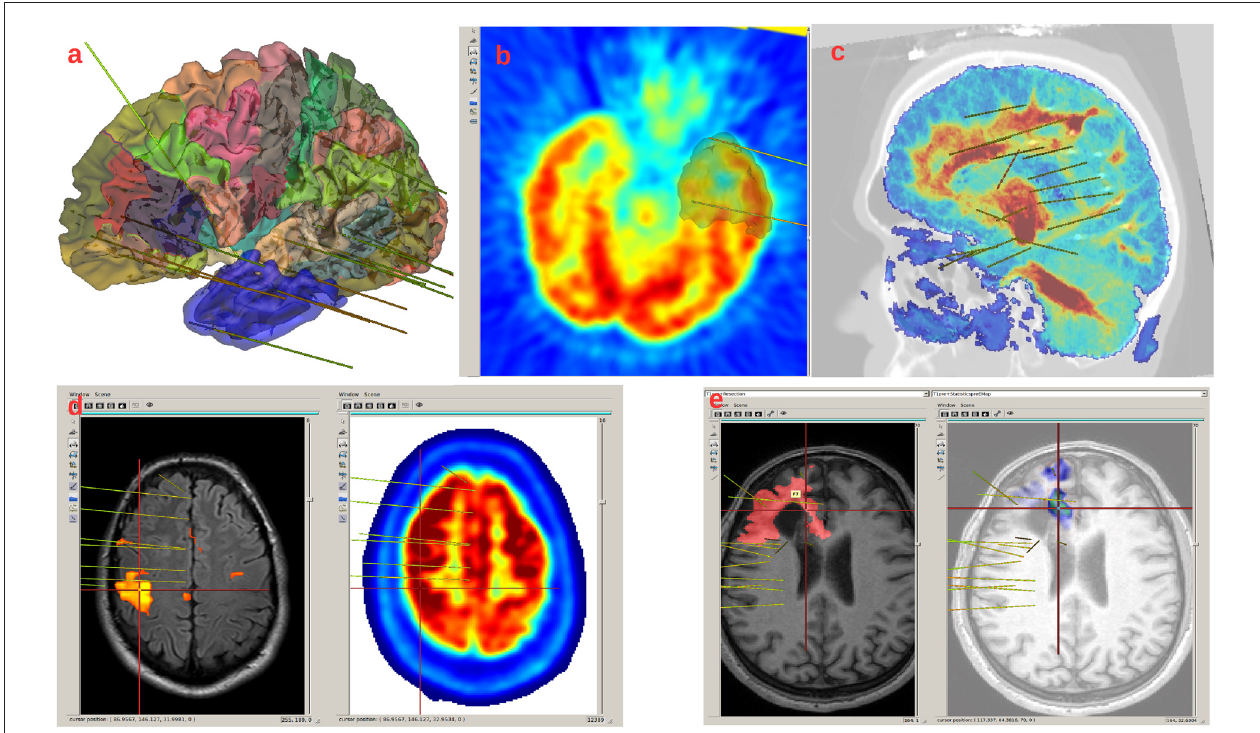
FIGURE 5 | Example of images displayed in LocateElectrodes interface. (A) MarsAtlas parcellation on the white matter mesh, with the mesh of the resection in transparent blue. (B) PET and resection mesh in gray. (C) Fusion of the T1MRI and the Diffusion Tensor Imaging (DTI) reconstruction (the colormap codes for the number of fibers, obtained from FSL software), (D) fMRI result on the left, PET on the right, (E) T1 and resection mask in red on the left, fusion of the T1 and the Epileptogenicity Index map on the right.